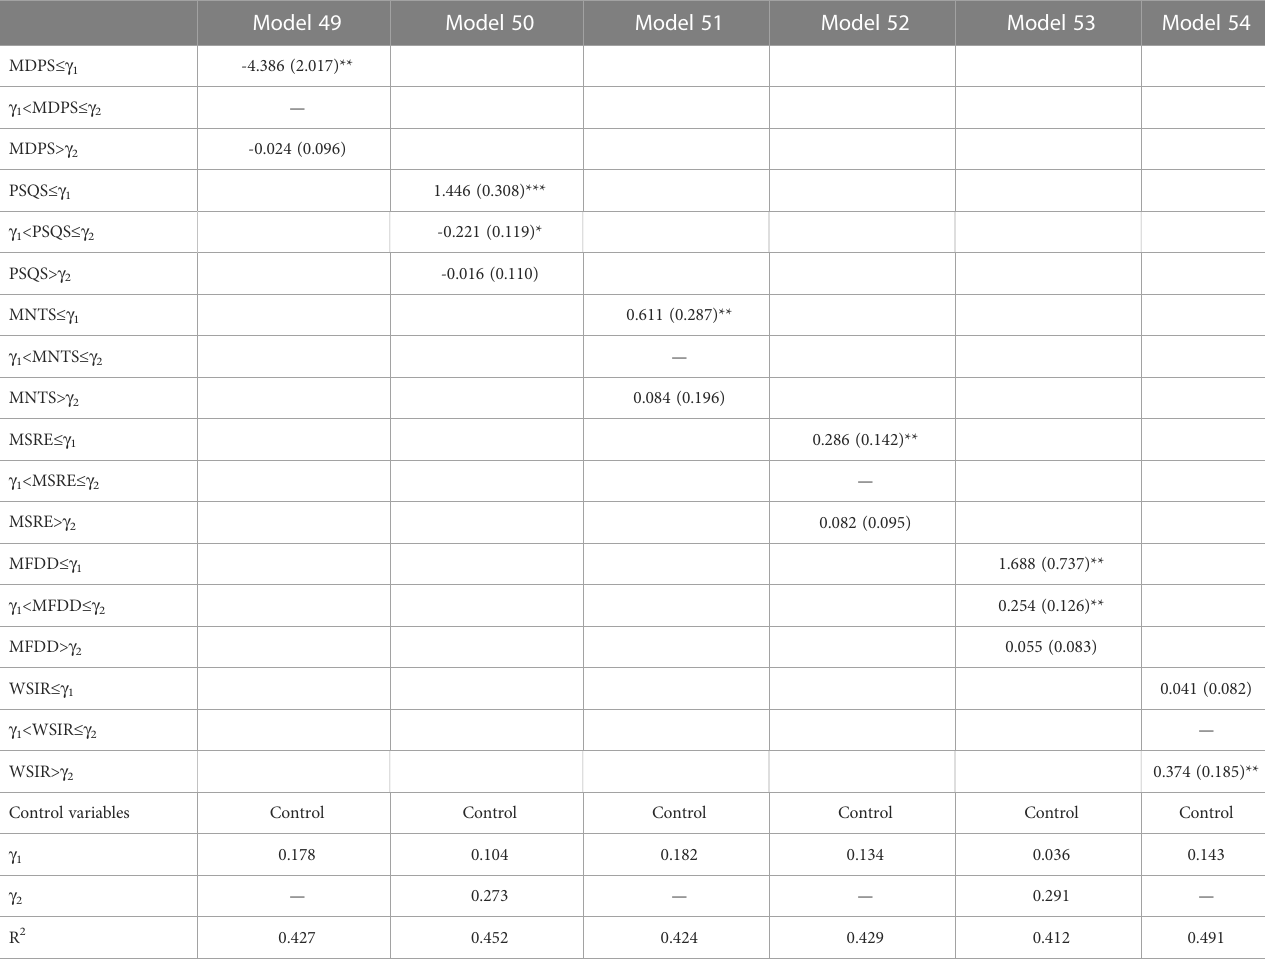
TABLE 9 The threshold model results of GTCG in the non-major grain producing